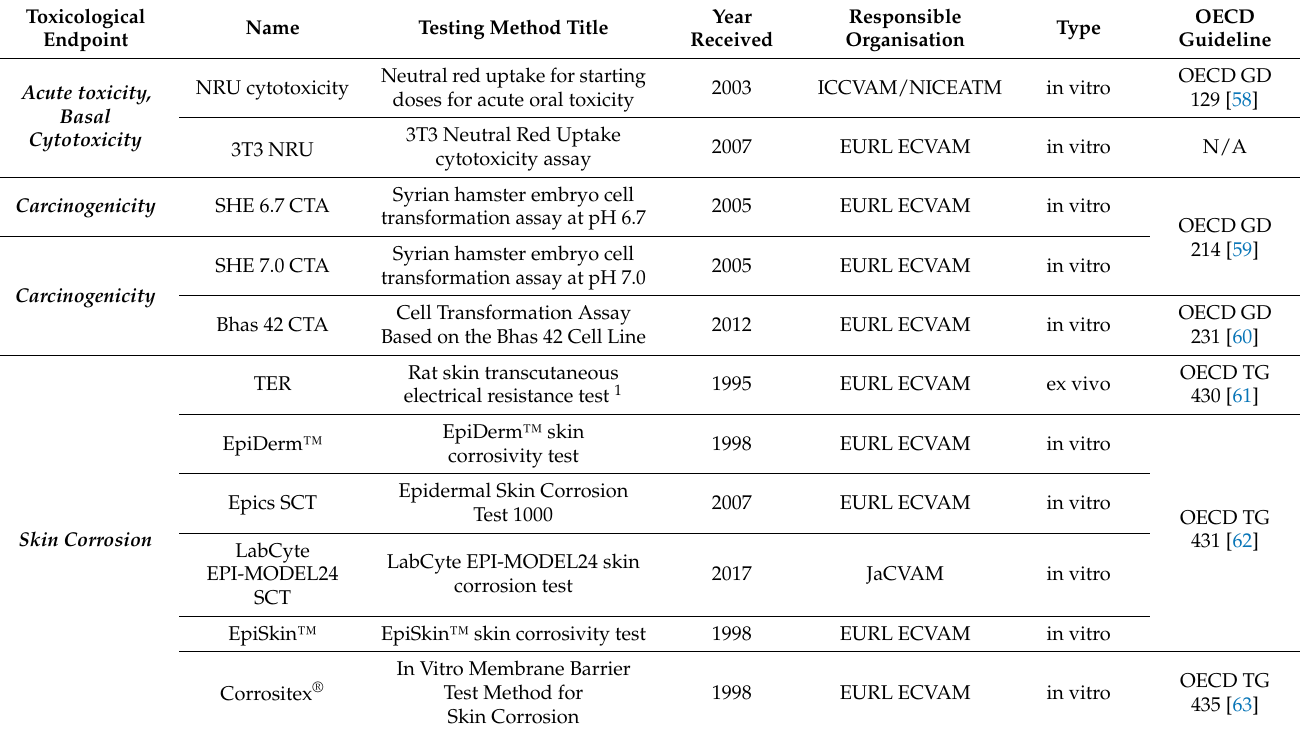
Table 3. Adopted NAMs relating to toxicological endpoints relevant to human hazard assessment in cosmetics, based on TSAR (modified from [37]).